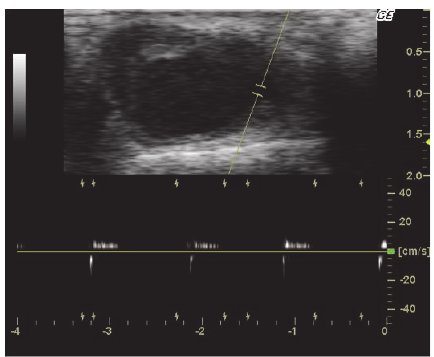
Figure 4: “To and fro” pattern.